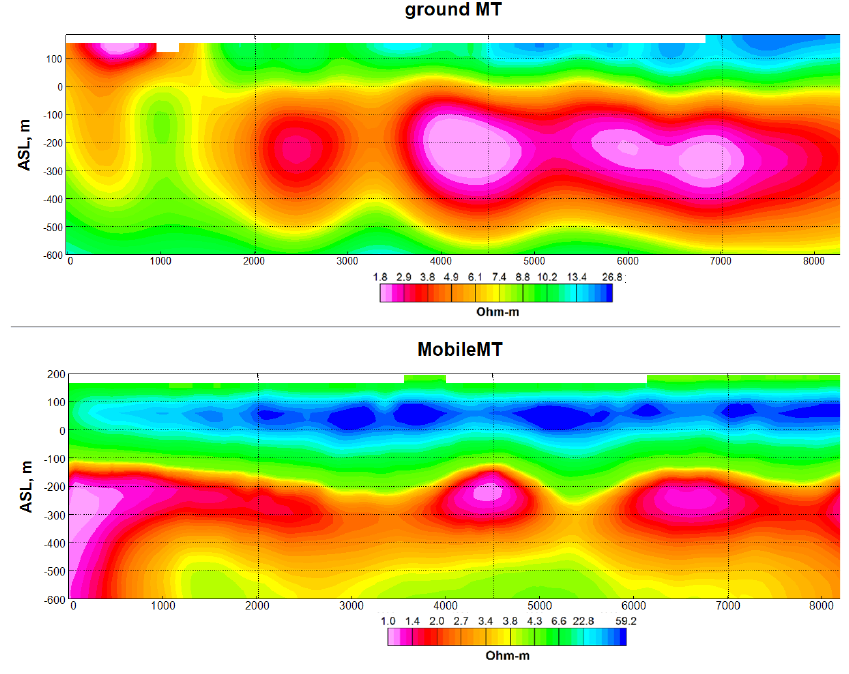
Figure 10. Resistivity sections over the same line derived and inverted from MobileMT and from ground MT data provided by CODA Minerals. Emmie Bluff block. ground MT data provided by CODA Minerals. Emmie Bluff